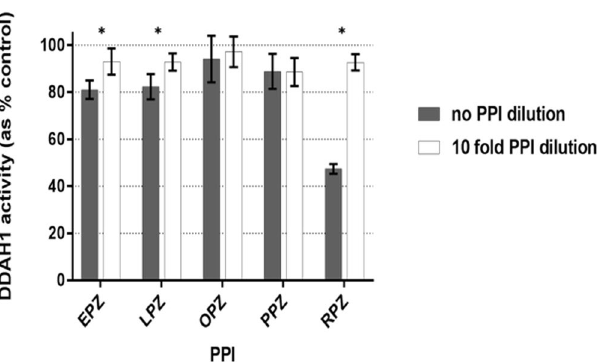
Figure 3. Reversibility of PPI binding to DDAH1. Measurement of DDAH1 activity is expressed as percentage of control activity (incubation with no PPI). Each data point represents the mean of two sets of triplicate experiments (10-fold PPI dilution) or one triplicate experiment (no PPI dilution). Error bars indicate the standard deviation. * P < 0.05; ** P <